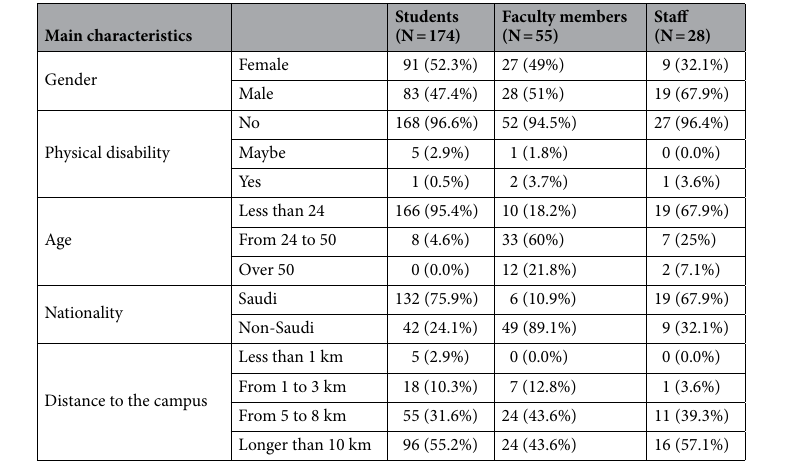
Table 1. Respondents’ statistics (N =